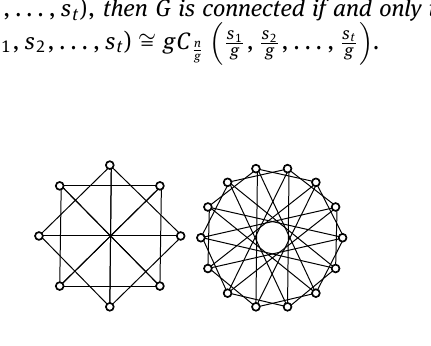
Figure 4: The disconnected circulant graphs C 8 (2, 4) ∼ = 2 K 4 = K 4 ∪ K 4 , and C 14 (2, 6) ∼ = 2 C 7 (1, 3) .